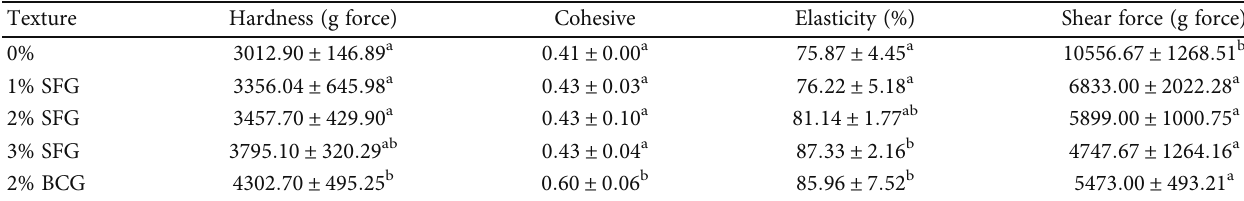
a, b, c Symbols on the same line indicate signi fi cant di ff erences ( p < 0 : 05 ). Mean ± Stdev ( n = 3 ). SFG = snakehead fi sh skin gelatin; BCG = commercial gelatin sourced from bovine bone. Table 3: Sausage texture pro fi le using di ff erent gelatin level